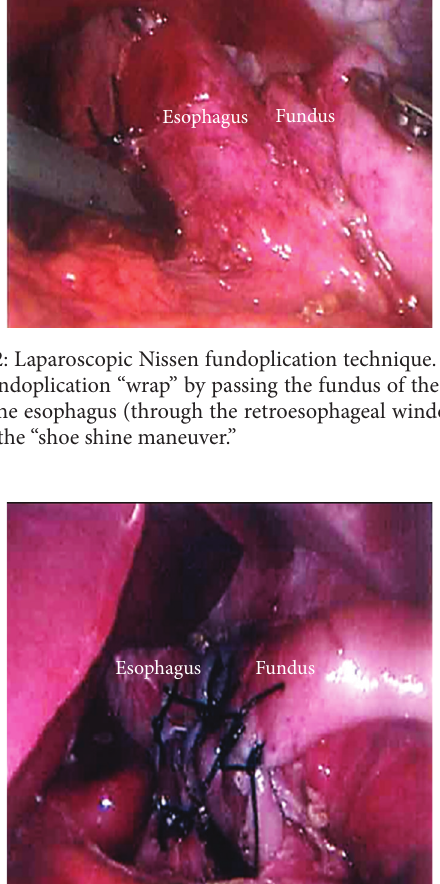
Table 4: Essential steps to the laparoscopic Nissen. See Figures 1–3 for images of these steps.